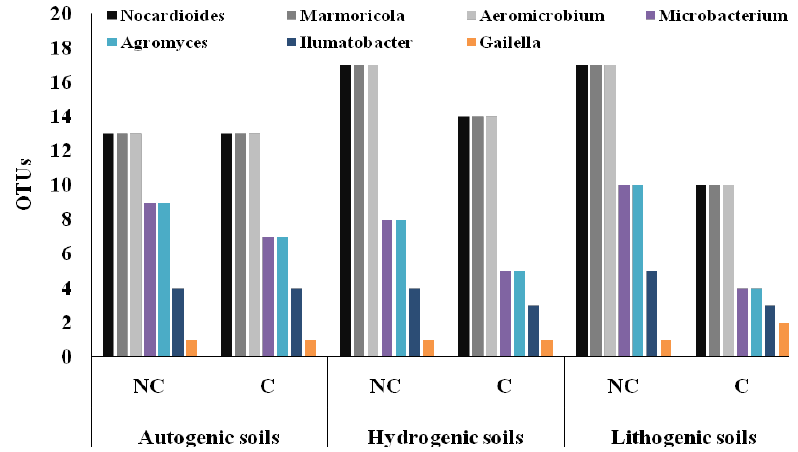
Figure 4. Relative abundance of seven dominant genera of Actinobacteria across all soil samples (NC– non-cultivated soil; C–cultivated soil) classified according to soil formation processes (autogenic, hydrogenic, and lithogenic).